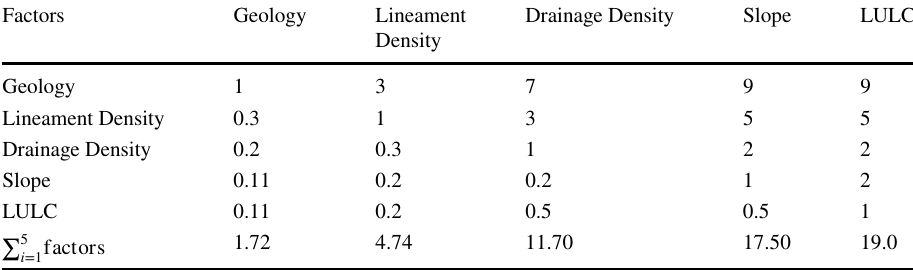
Table 4 Pairwise comparison matrix of influencing